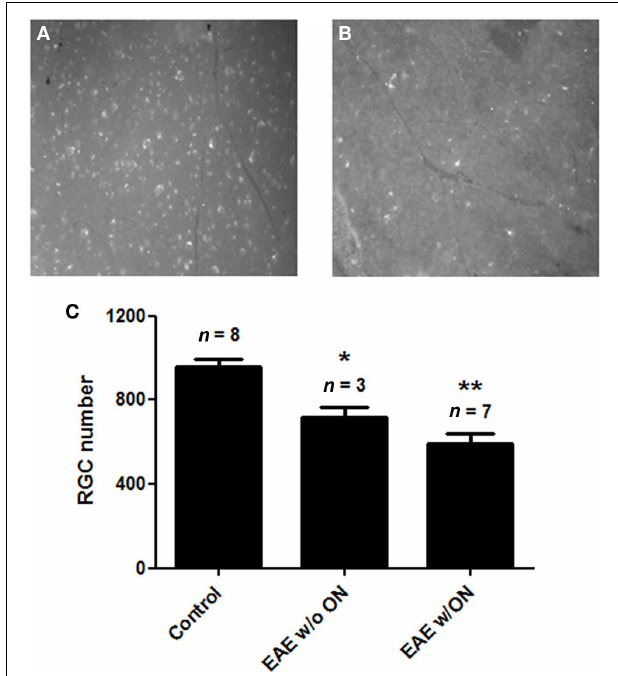
FIGURE 3 | Retinal ganglion cell numbers decreased in EAE eyes 50days after immunization. RGCs of C57/BL6 mice were retrogradely labeled with fluorogold by stereotactic injection into the superior colliculi. Mice were immunized with MOG or sham injected with PBS, and were sacrificed 50days post-immunization. Dissected retina from each eye was viewed by fluorescent microscopy. Optic nerve from each eye was examined histologically for presence of inflammatory cell infiltrates. (A) Representative photograph shown at original magnification × 20 demonstrates numerous fluorescent-labeled RGCs observed in retina from a control (non-EAE) mouse eye. (B) Fewer RGCs found in the retina from an EAE mouse eye. (C) RGC numbers were counted in 12 standardized fields from each retina.The number of RGCs present in control eyes was significantly higher than the number of RGCs in eyes from EAE mice that did not contain histologic evidence of ON (* p = 0.006) and EAE eyes with ON (** p = 0.00003).